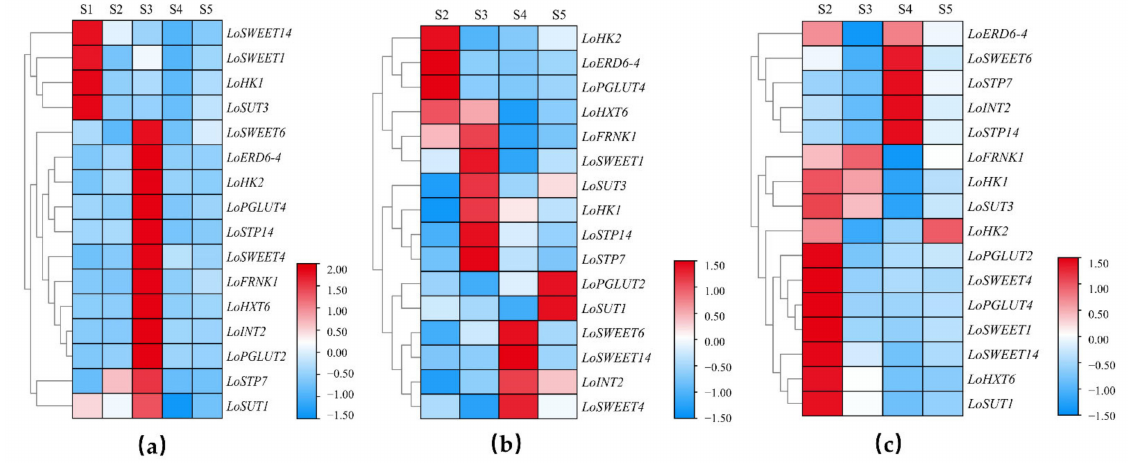
Figure 4. Expression heatmap of ST genes during sugar transport in lily in different tissues. ( a ) Ex- pression heatmap in bulb. ( b ) Expression heatmap in stem. ( c ) Expression heatmap in leaf.